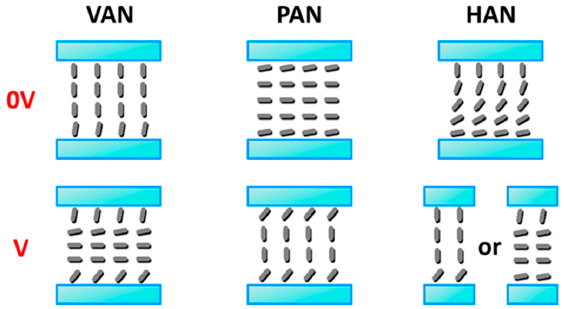
Figure 3. Typical alignment modes that can be used in LC contact lenses. Vertically aligned nematic (VAN), Planar aligned nematic (PAN) and hybrid aligned nematic (HAN) are pre-determined by the alignment layer and must be matched with an LC with the appropriate dielectric anisotropy.